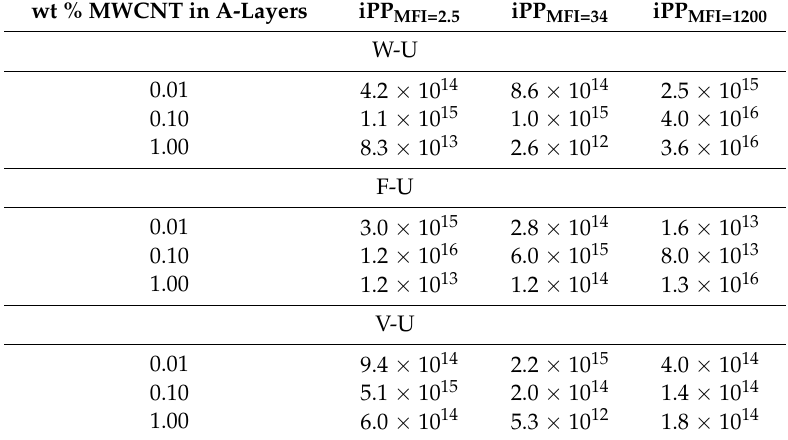
Table 2. Surface resistivity ( Ω /sq) for ABA films fabricated using masterbatches with MFI = 2.5, 34, and 1200 g/10 min. The masterbatches were fabricated using ultrasound-assist methods: W-U, F-U, and